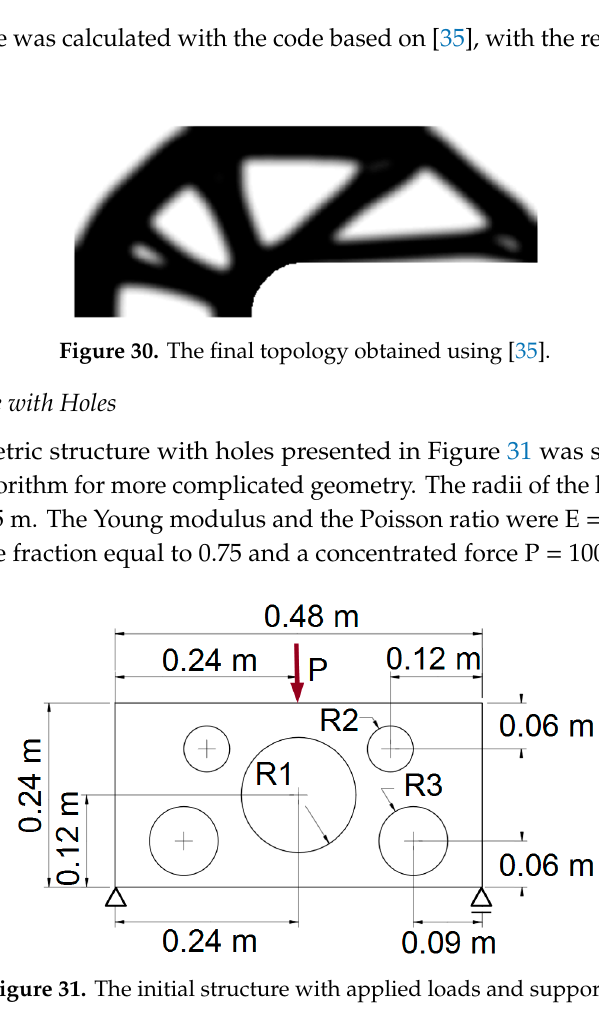
Figure 29. Iteration history for the knee structure.